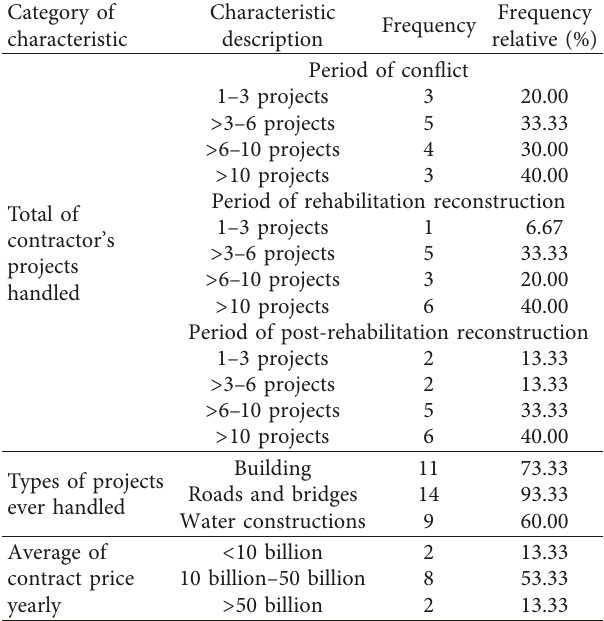
Table 5: Contractor firms characteristic of respondents.